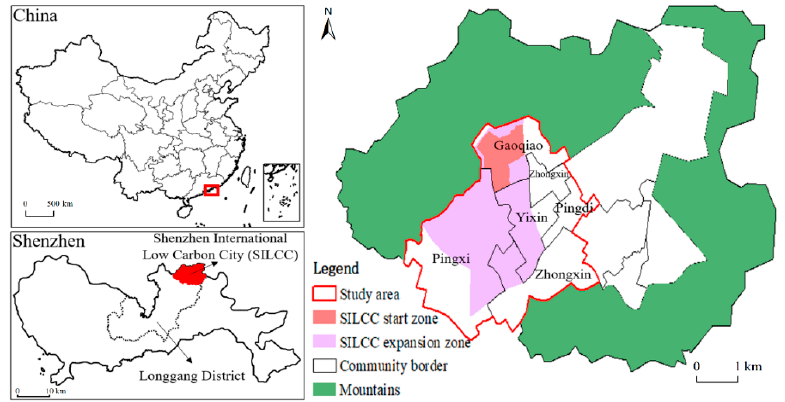
Figure 1. Location of the study area.